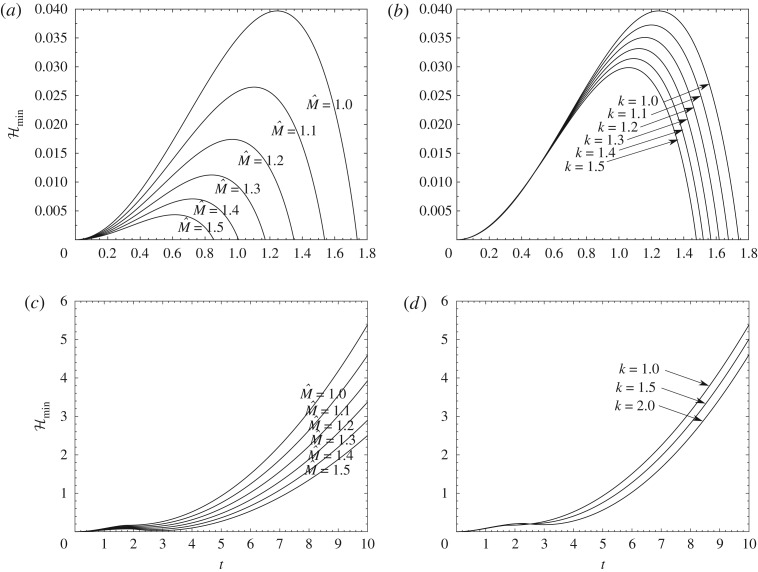
Numerical solutions of the minimum gap width Hmin against t in which the body returns to the surface in (a, b) but flies away in (c, d). The effect of scaled mass M^ ranging from (a, c) 1 to 1.5. The effect of κ (written as k) ranging from (b) 1 to 1.5 and (d) 1 to 2. In (a, c), the scaled moment of inertia I^ also changes according to I^=ΓM^, for Γ = 0.2. Here a symmetrical sinusoidal shaped body is investigated; fu = κsin(πx).